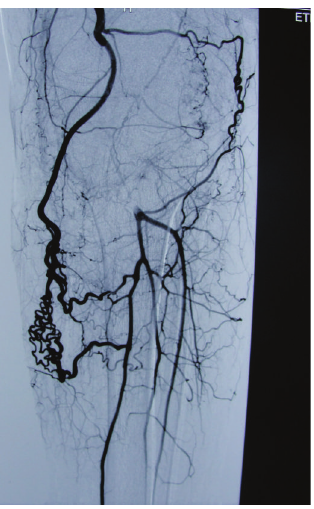
Figure 3: The arteriography of the popliteal mass which showed the occluded popliteal artery and the distal flow with collateral